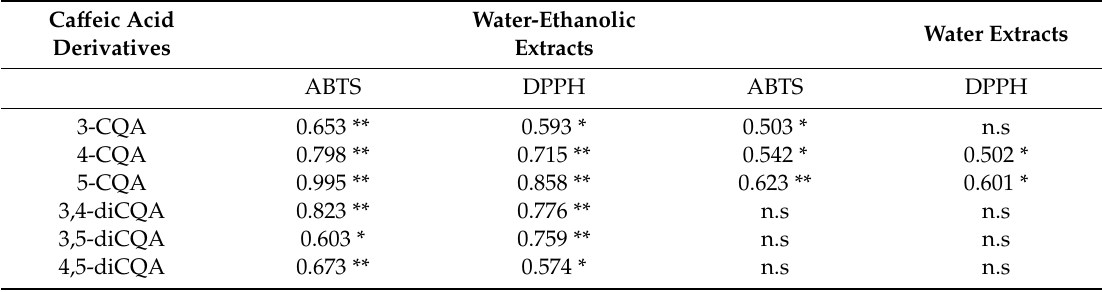
Table 3. Correlation coe ffi cients ( r ) between di ff erent ca ff eic acid derivatives and antioxidant activity in water and water-ethanolic extracts from medicinal